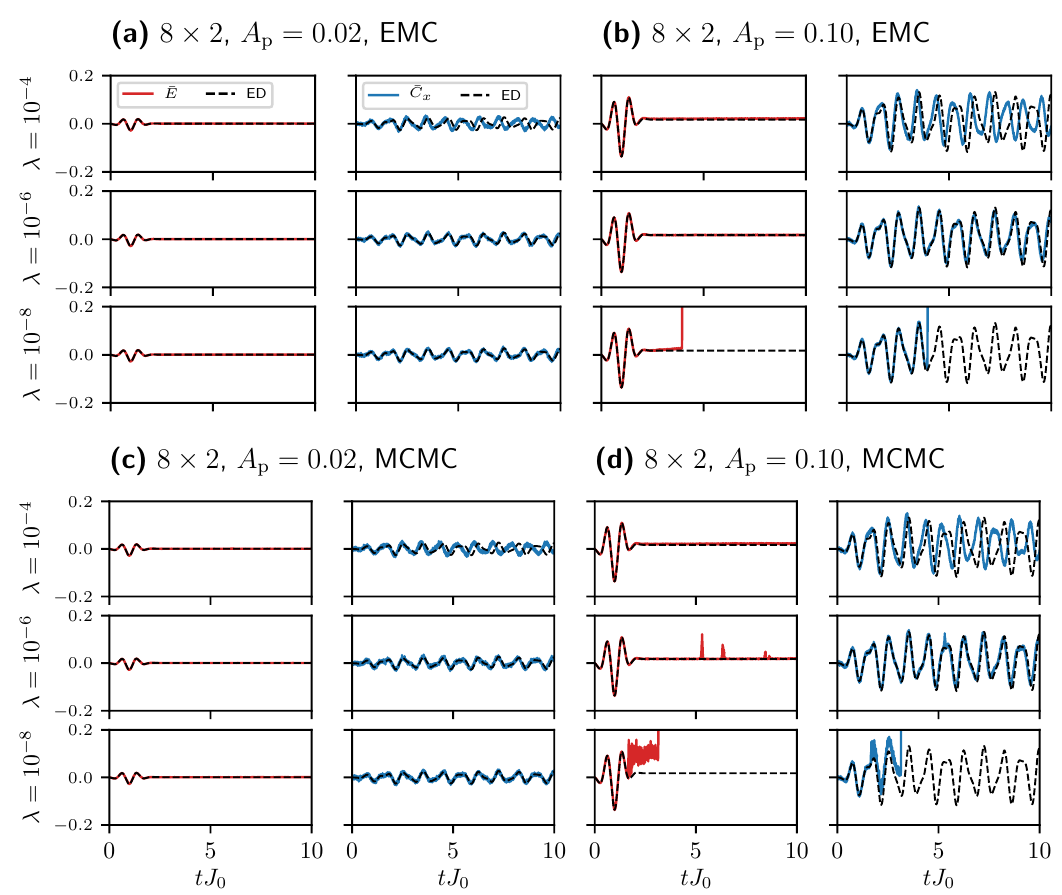
Figure 7: Relative change in energy and x -bond correlation as defined in Fig. 3 for a selection of trajectories shown in Fig. 6 with different regularization strengths λ